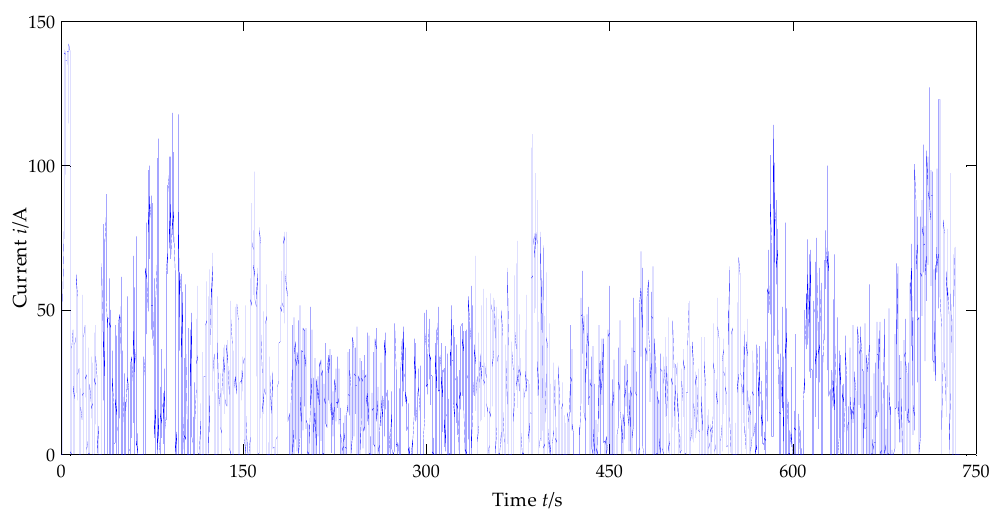
Figure 8. The required current of EPS under the test conditions.